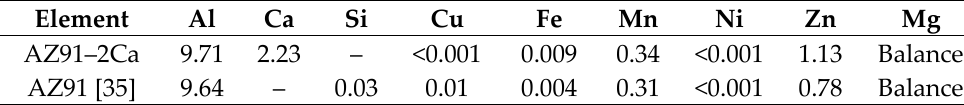
Table 1. Chemical Composition of the AZ91–2Ca alloy (wt.%).